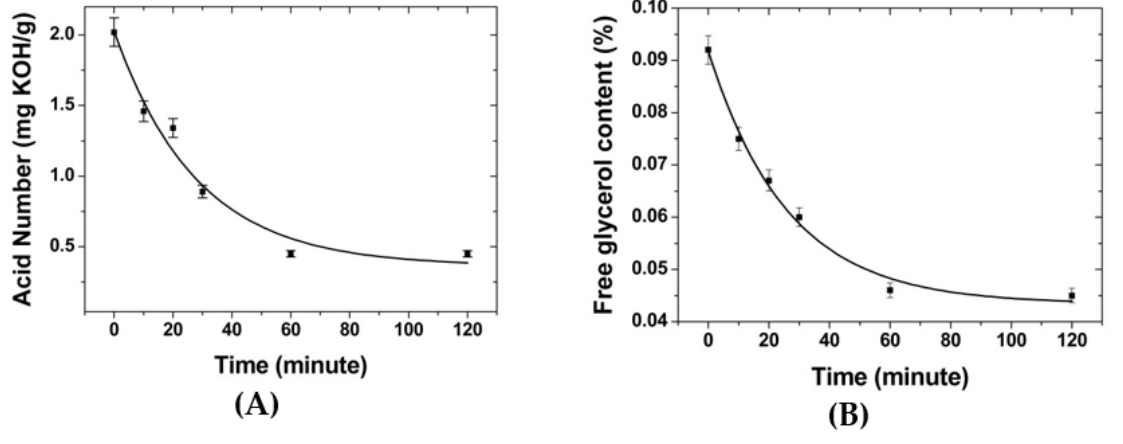
Figure 6. Effect of contact time on the reduction of ( A ) free glycerol content and ( B ) acid number in